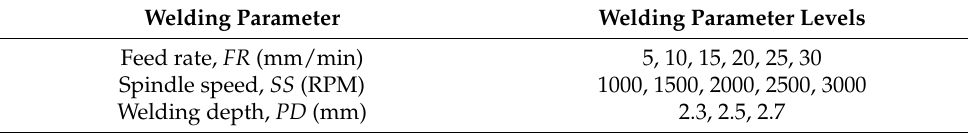
Table 2. Welding parameter levels obtained for experiment parametric study.